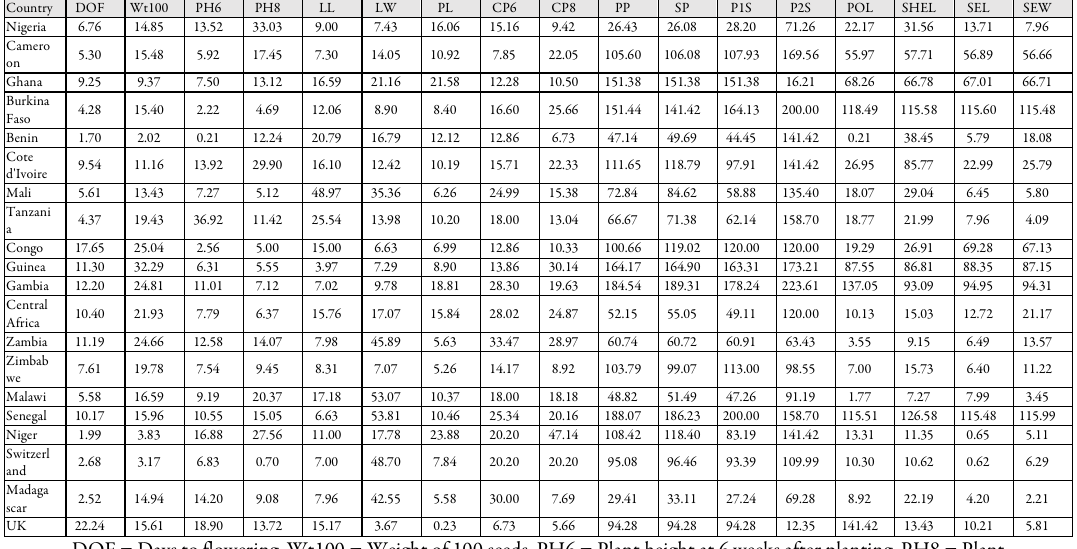
DOF = Days to flowering, Wt100 = Weight of 100 seeds, PH6 = Plant height at 6 weeks after planting, PH8 = Plant height at 8 weeks after planting, LL= Leaf length, LW=Leaf width, PL = Pod length, CP6 = Canopy at 6 weeks after planting, CP8 = Canopy at 8 weeks after planting, PP= Pods per plant, SP= Seed per plant, P1S= Pod with 1 seed, P2S= Pod with 2 seed, POL = Pod length, SHEL = shelling percentage, SEL = Seed length, SEW = Seed